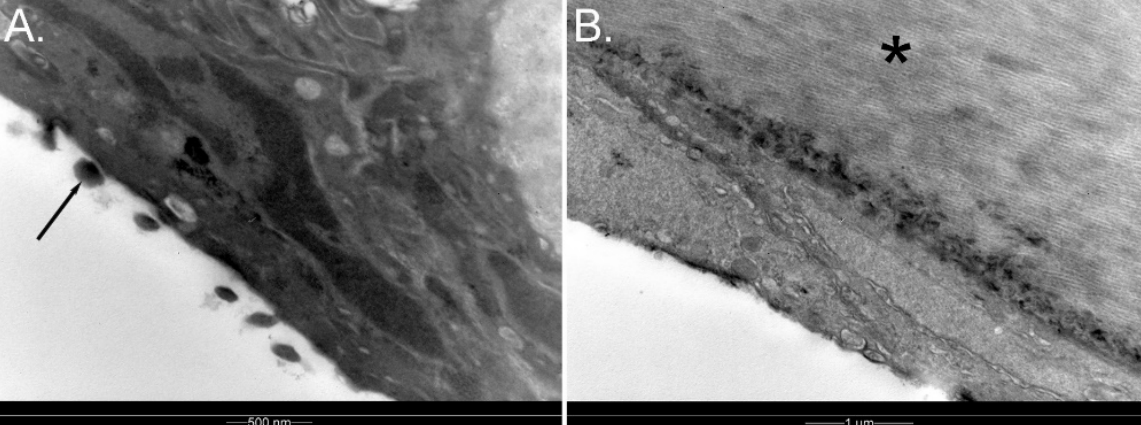
Figure 4. Transmission electron micrograph of Membrana nictitans of a gentoo penguin Pygoscelis Figure papua ; ( A ) Note the excrescences on the posterior surface (arrow); ( B ) There is a regular, parallel arrangement of collagen fibrils in the stroma (asterix) . Credit: PWH.